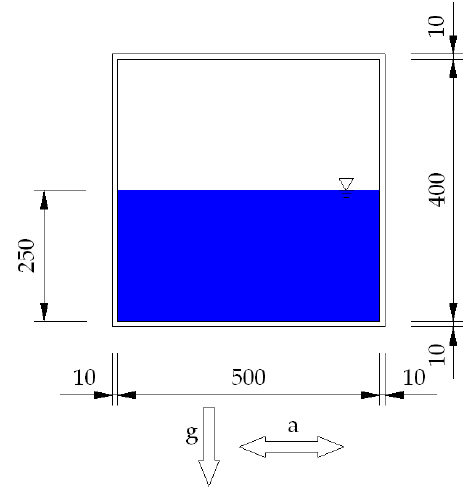
Figure 7. Analytical model for evaluating the effects of earthquake of different shapes.